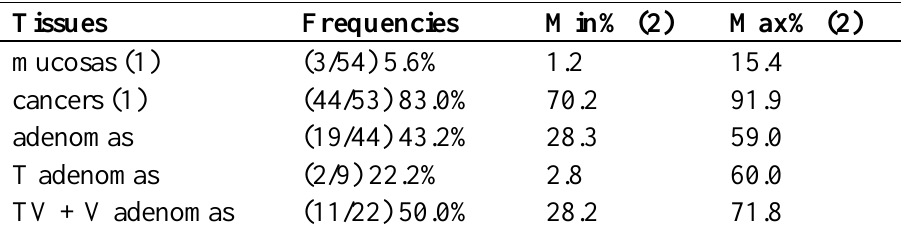
Table 2. (a) Hypomethylation frequency in various tissues.